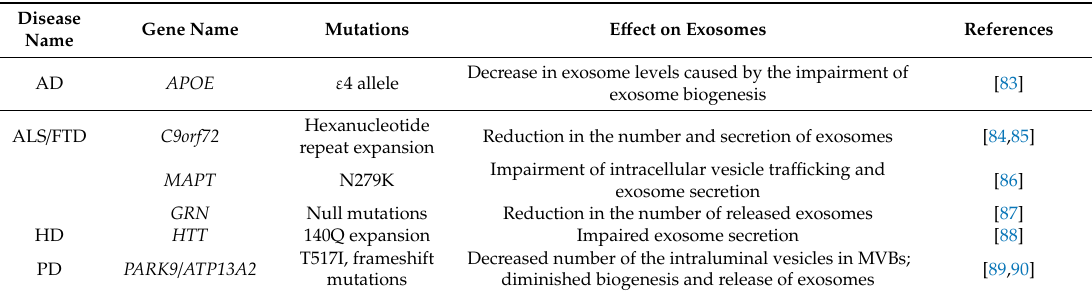
Table 2. Genetic alterations in ND genes a ff ecting exosome